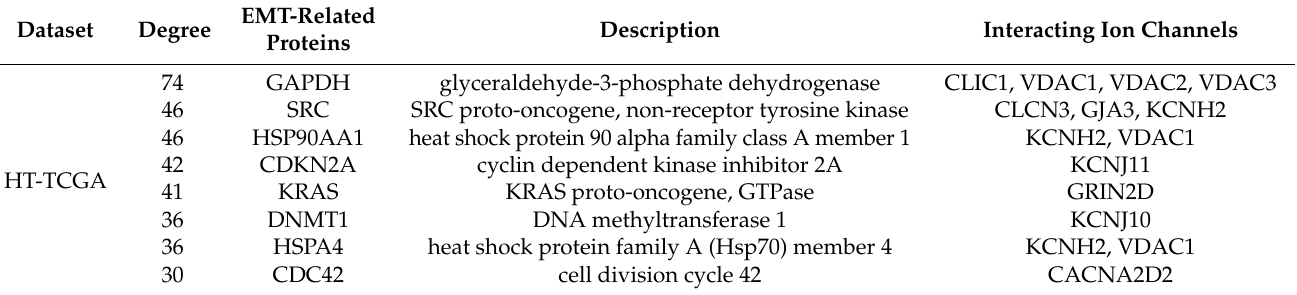
Table 5. A list of ion channels interacting with the top 15 EMT-related proteins with the highest degree centrality measure in protein–protein interaction networks of modules on HT DEGs in breast cancer TCGA dataset.